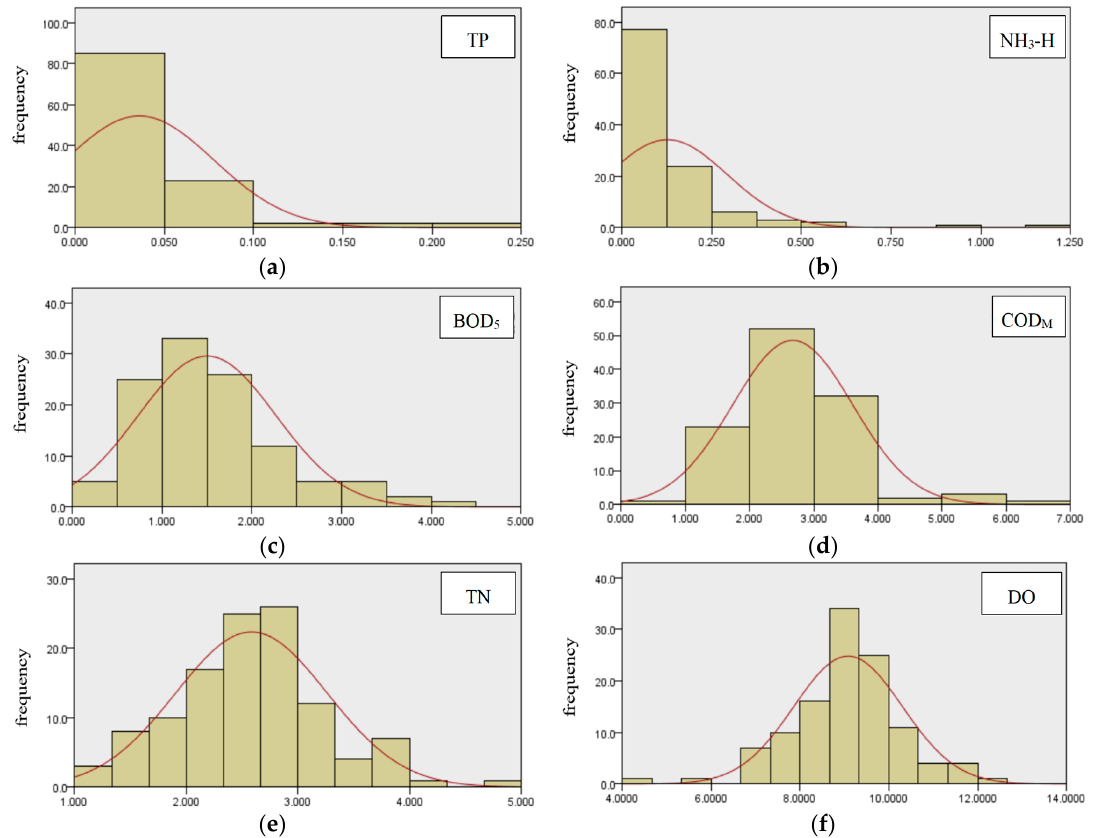
Figure 2. Frequency distribution map of water quality indicators. (Yellow columns represent the frequency of occurrence of concentrations and the red lines are the concentration frequency distribution curves).